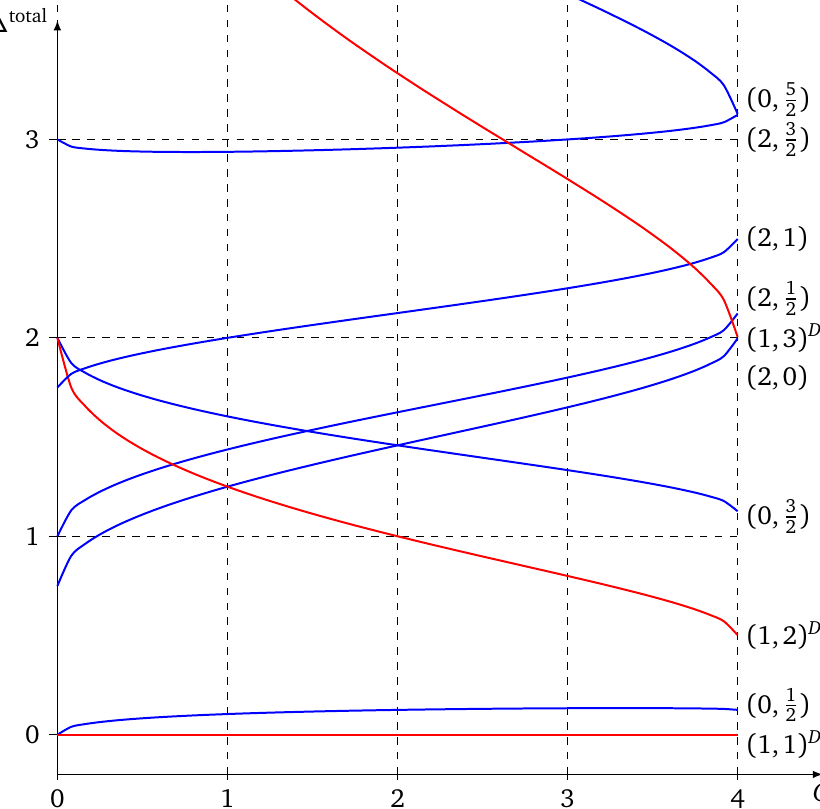
Figure 2.1: Conformal dimensions of low-lying states in the Potts model as functions of Q . We use red for S D